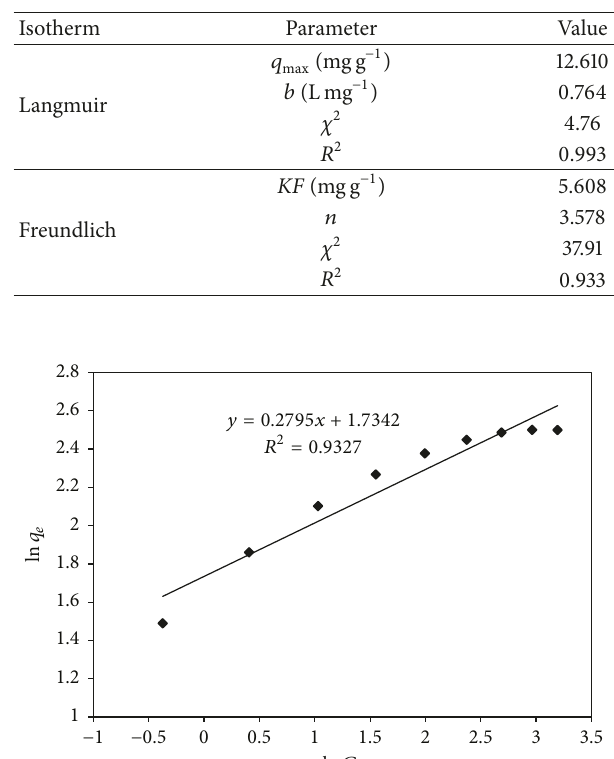
Table 5: Thermodynamic parameters.